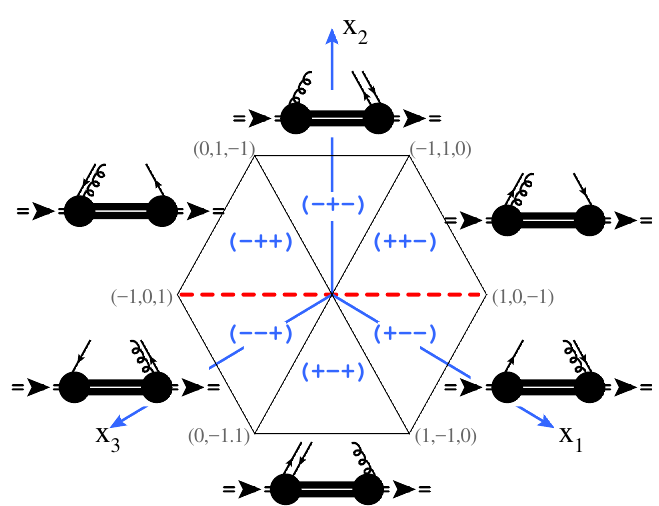
Figure 6 . The support of the twist-3 functions, drawn in the barycentric coordinates, x 1 + x 2 + x 3 = 0. The diagrams demonstrate the interpretation of distribution in the terms of emission-absorption of partons by a hadron. Red dashed line is the line on which the Qui-Sterman distribution is